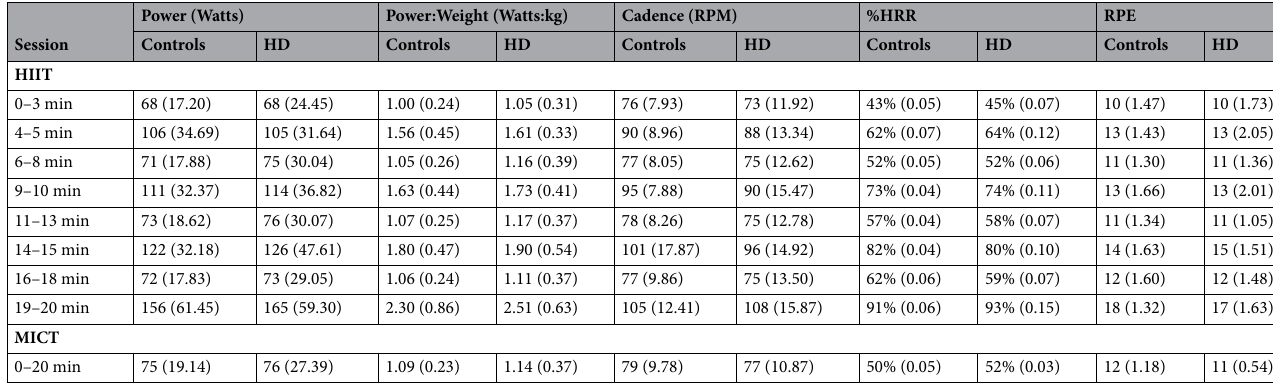
Table 2. Effects of high-intensity interval training and moderate-intensity continuous training on exercise performance. Data are mean (SD). HIIT high-intensity interval training, MICT moderate-intensity